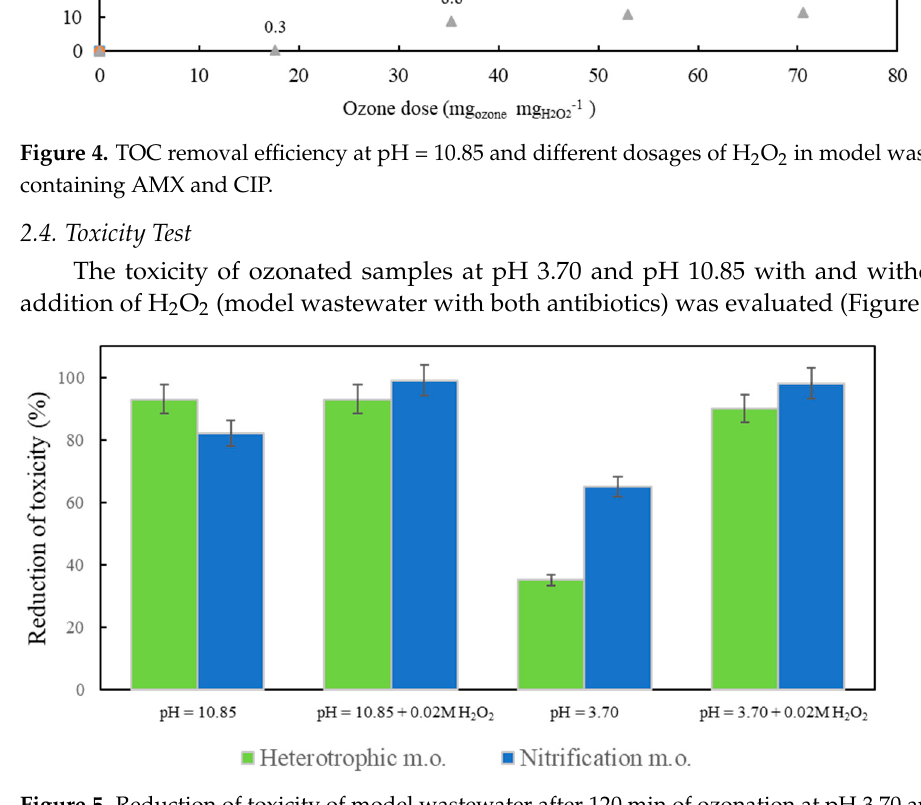
Figure 5. Reduction of toxicity of model wastewater after 120 min of ozonation at pH 3.70 and 10.85 with and without addition of 0.02 M H 2 O 2